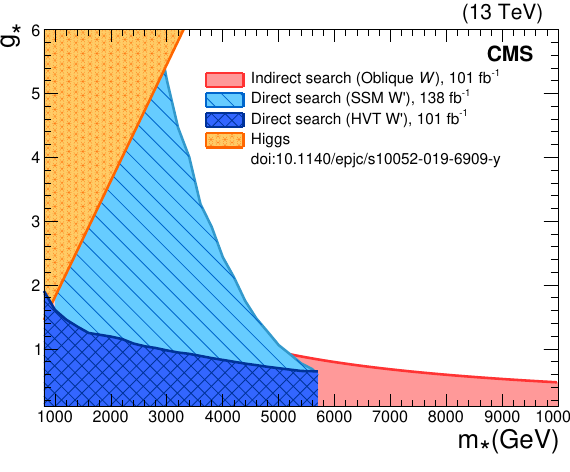
- g plane excluded at 95% CL by the results derived in the framework Figure 11 . Regions in the m ∗ ∗ of the different models considered in the current analysis. Constraints from the limit on the oblique W parameter are shown in red. Constraints from the limit on the W 0 boson coupling strength are shown in light blue for the SSM W 0 hypothesis (only coupling to fermions), and in dark blue for the HVT W 0 hypothesis (coupling to bosons as well). In addition, the exclusion coming from current CMS constraints on the Higgs boson cross section is shown as a orange shaded